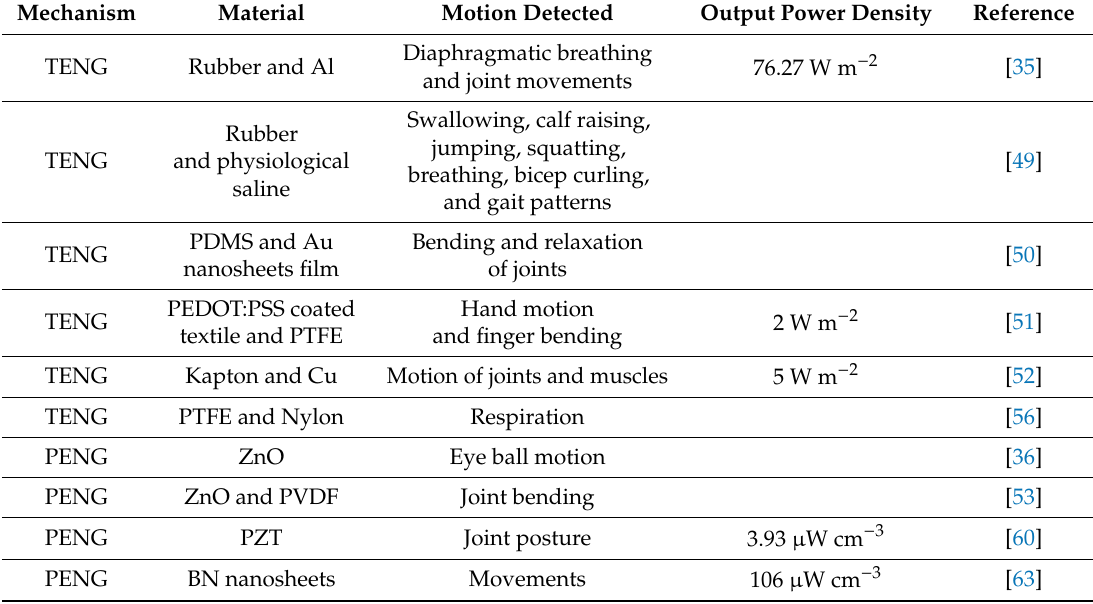
Table 1. Comparison of self-powered skin sensors for detecting body